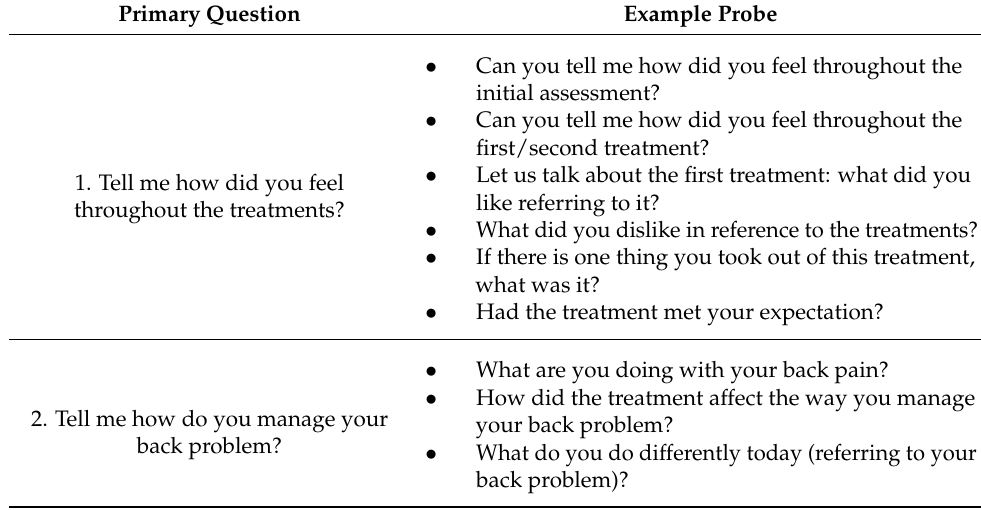
Table 1. Semi-structured interview guide.